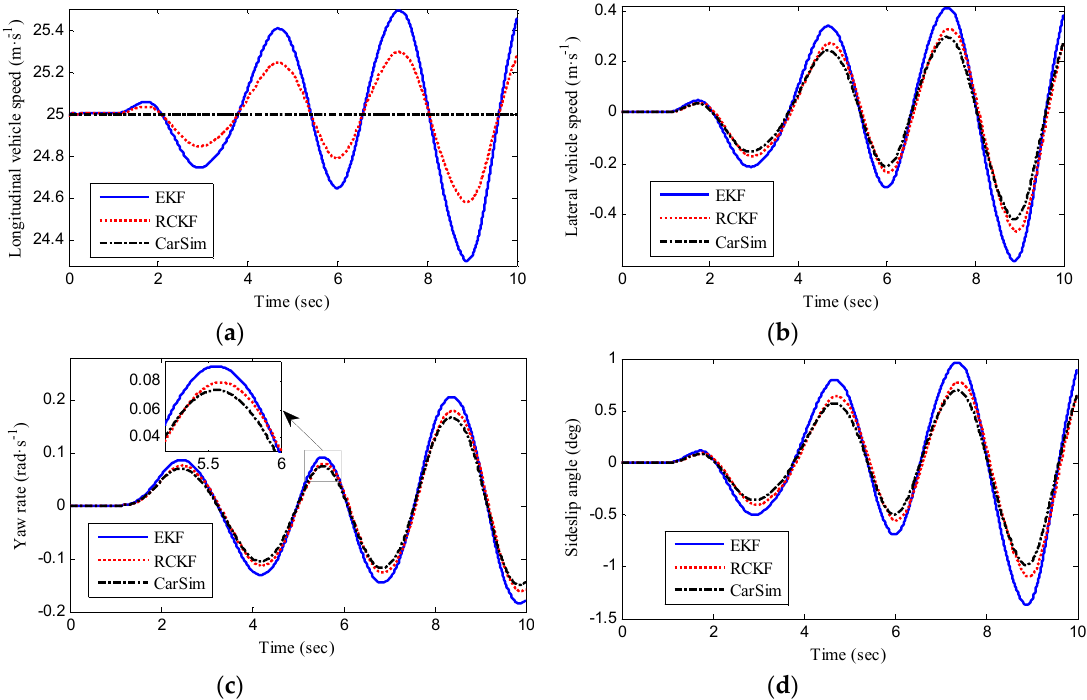
Figure 3. Comparison of estimation effects in double lane changes maneuver: ( a ) Longitudinal vehicle speed; ( b ) lateral vehicle speed; ( c ) yaw rate; ( d ) sideslip angle.